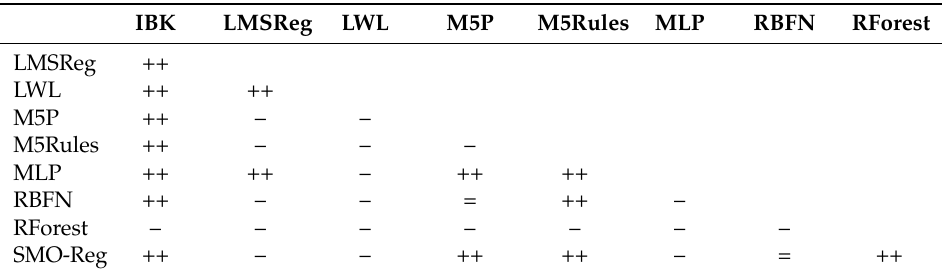
Table 4. Statistical significance of differences of median underpricing RMSEs on the test set according to the Mann–Whitney test. Positive signs indicate higher prediction errors for the algorithm in the columns vs. the algorithms in the